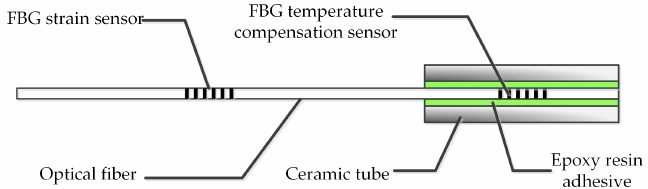
Figure 1. Fiber Bragg Grating (FBG) strain sensor and FBG temperature compensation sensor in an optical fiber.